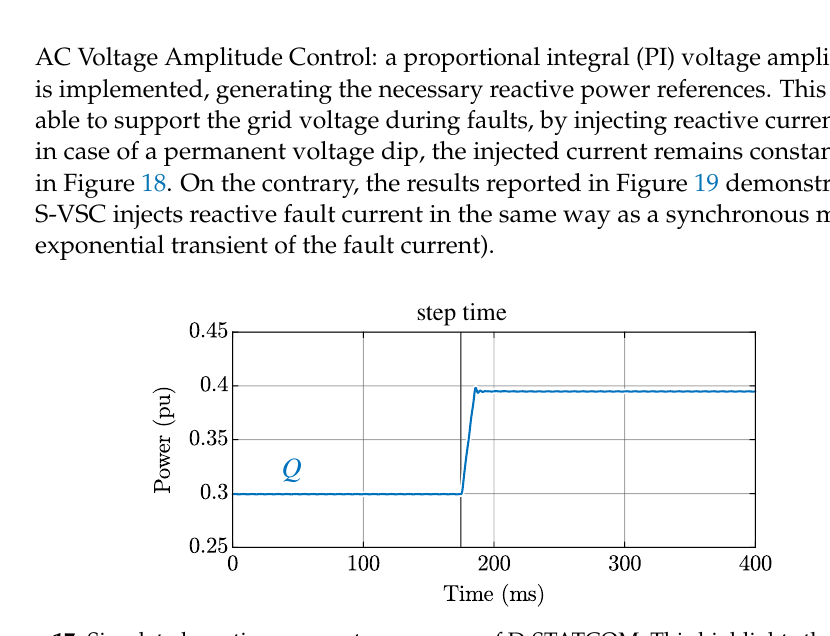
Figure 17. Simulated reactive power step response of D-STATCOM. This highlights the capability of injecting or absorbing reactive power and therefore contributing to the regulation of the voltage.